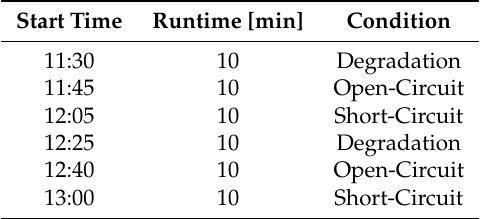
Table 2. Fault Schedule for Real